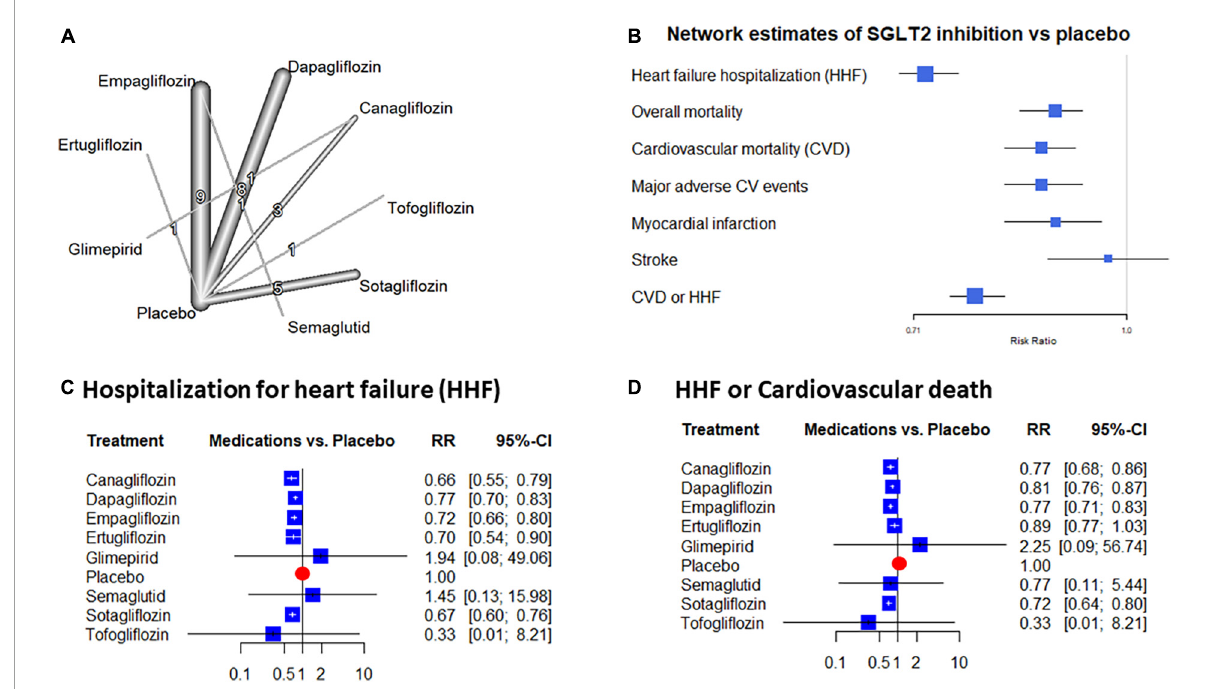
FIGURE2 Evidence network and network estimates of the placebo compared effects: The network graph shows the individual treatment arms of the included trials depicting treatments as nodes and direct comparisons as edges. The numbers and the thickness of the edges show the direct comparisons performed (A) . (B) Depicts the estimates of gliflozin treatment compared to placebo extracted from the random effects network. (C,D) Show forest plots of heart failure hospitalization (HHF) and the HHF + cardiovascular mortality (CVD) endpoints. The relative risk (RR) values are presented as squares with whiskers showing their 95% confidence interval.